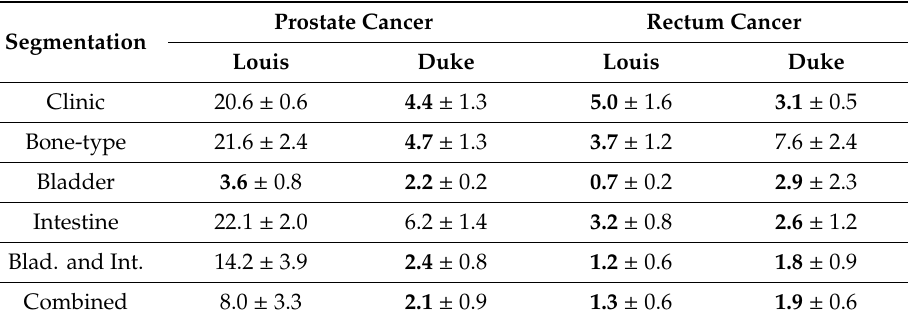
Table 4. The impact of di ff erent segmentation on the simulated hyperthermia dose within males. This was quantified in the absolute value of the relative di ff erence in THQ ( | dTHQ | ). Note that the evaluation for each model and segmentation was the maximum between the three di ff erent sizes. | dTHQ | values approximately equal and below 5%, i.e., the threshold for clinical relevance (~0.2 ◦ C), are given in boldface. For each cancer type and model, maximum values and their standard deviation are